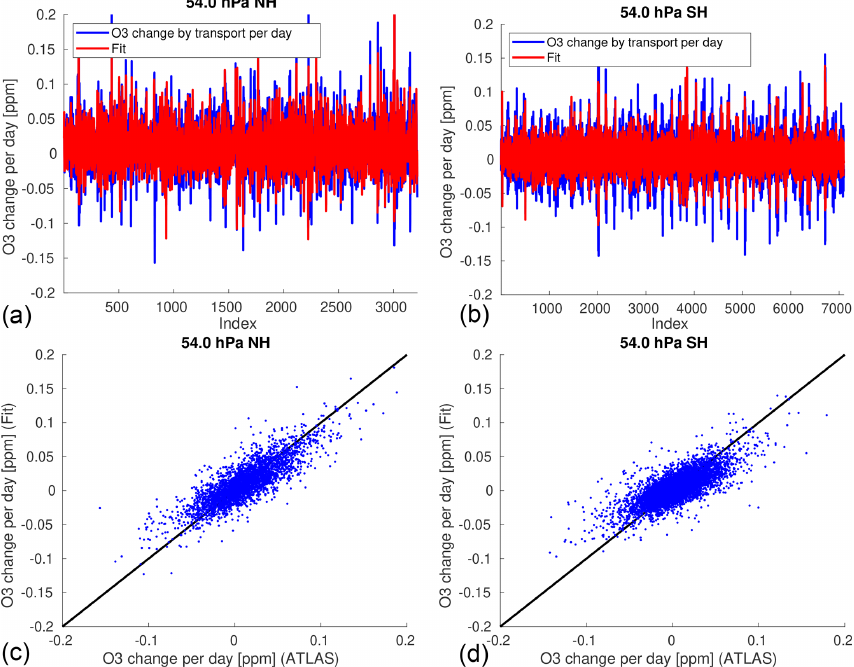
Figure 2. Concatenated time series of the change of vortex-averaged ozone mixing ratio by transport per day for all years in ATLAS–SWIFT at 54hPa (blue) and corresponding fit from the multivariate regression model (red). (a) Northern Hemisphere, (b) Southern Hemisphere; (c) and (d) show the same data as a scatter